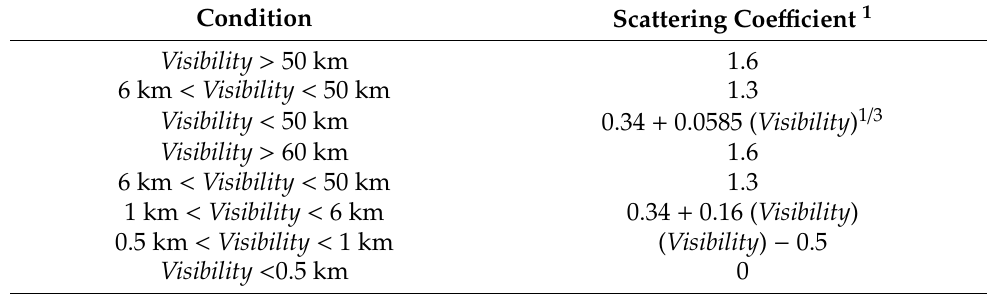
Table 2. Scattering coefficient.